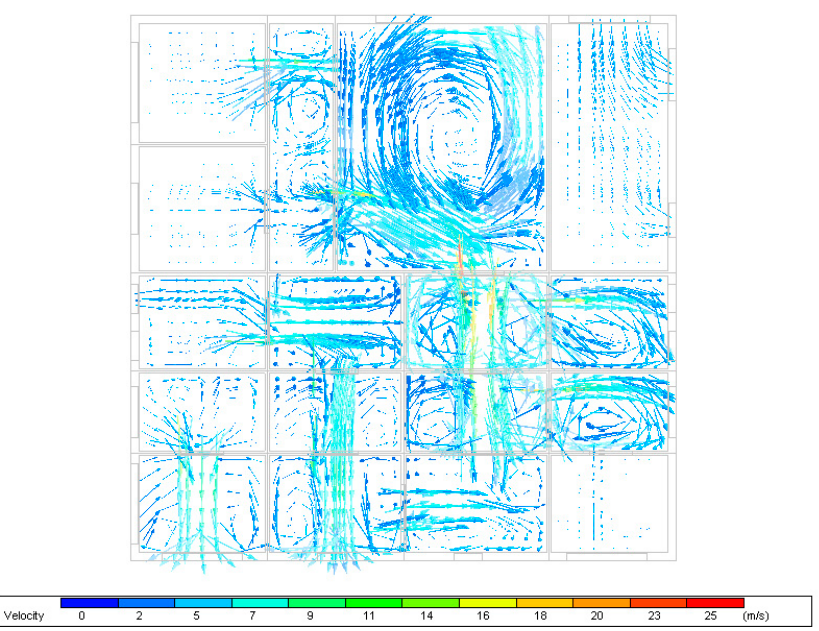
Figure 11. Velocity and airflow patterns inside the building